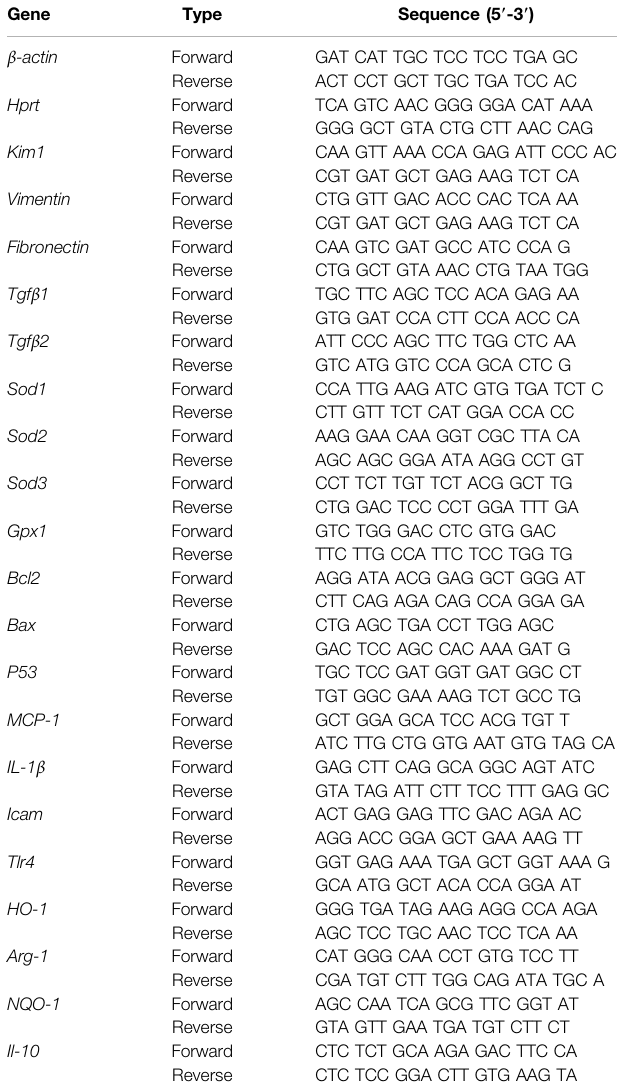
TABLE 1 | Primer sequences for the quantitative real-time polymerase chain reactions.